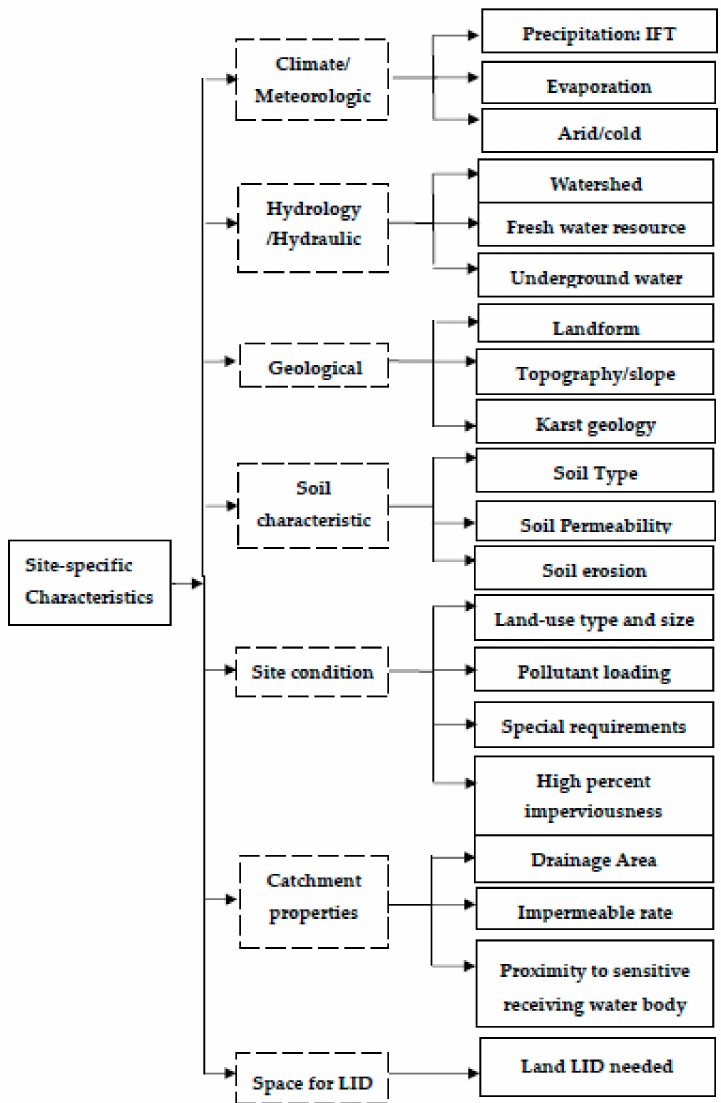
Figure 5. Site-specific